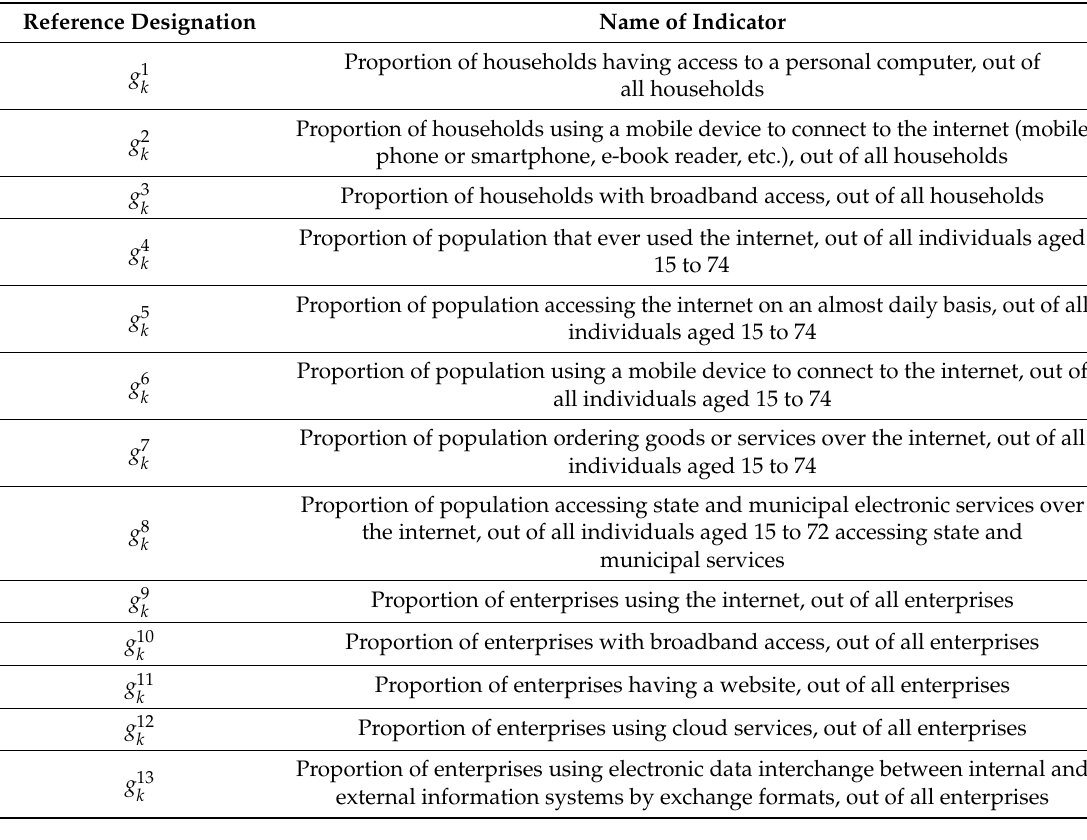
Table 1. Source indices for assessment of digitalization levels of subnational entities (%).